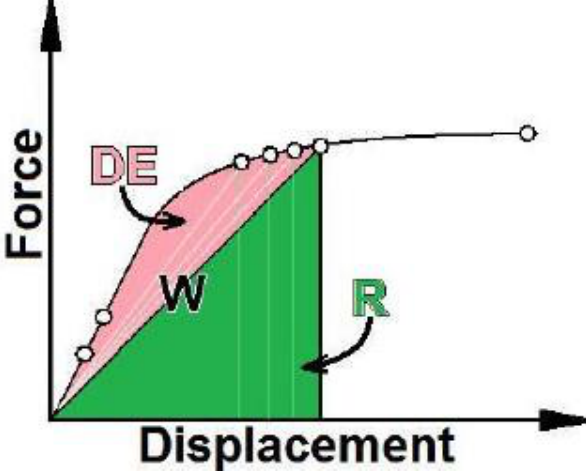
Fig. 13. The Force-Displacement diagram for the element.